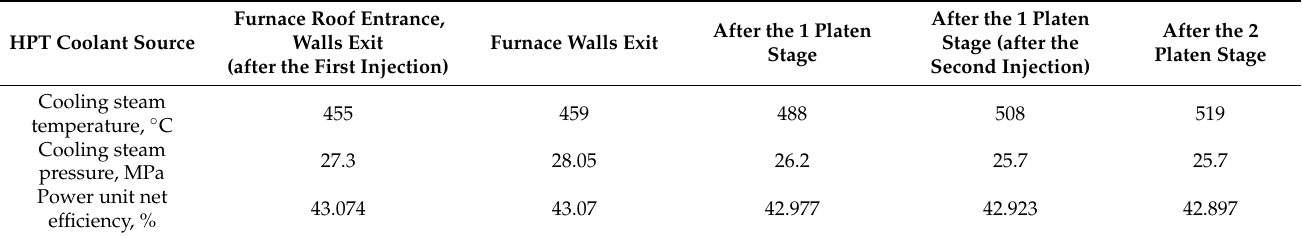
Figure 7. Power unit net efficiency for different coolant temperatures and production methods at the initial temperature of 720 °C: ( a ) Mixing of main steam with feed water; ( b ) steam extraction from the boiler header. Table 8. Power unit net efficiency with the turbine coolant steam taken from the boiler headers at the initial temperature of 720 °C.